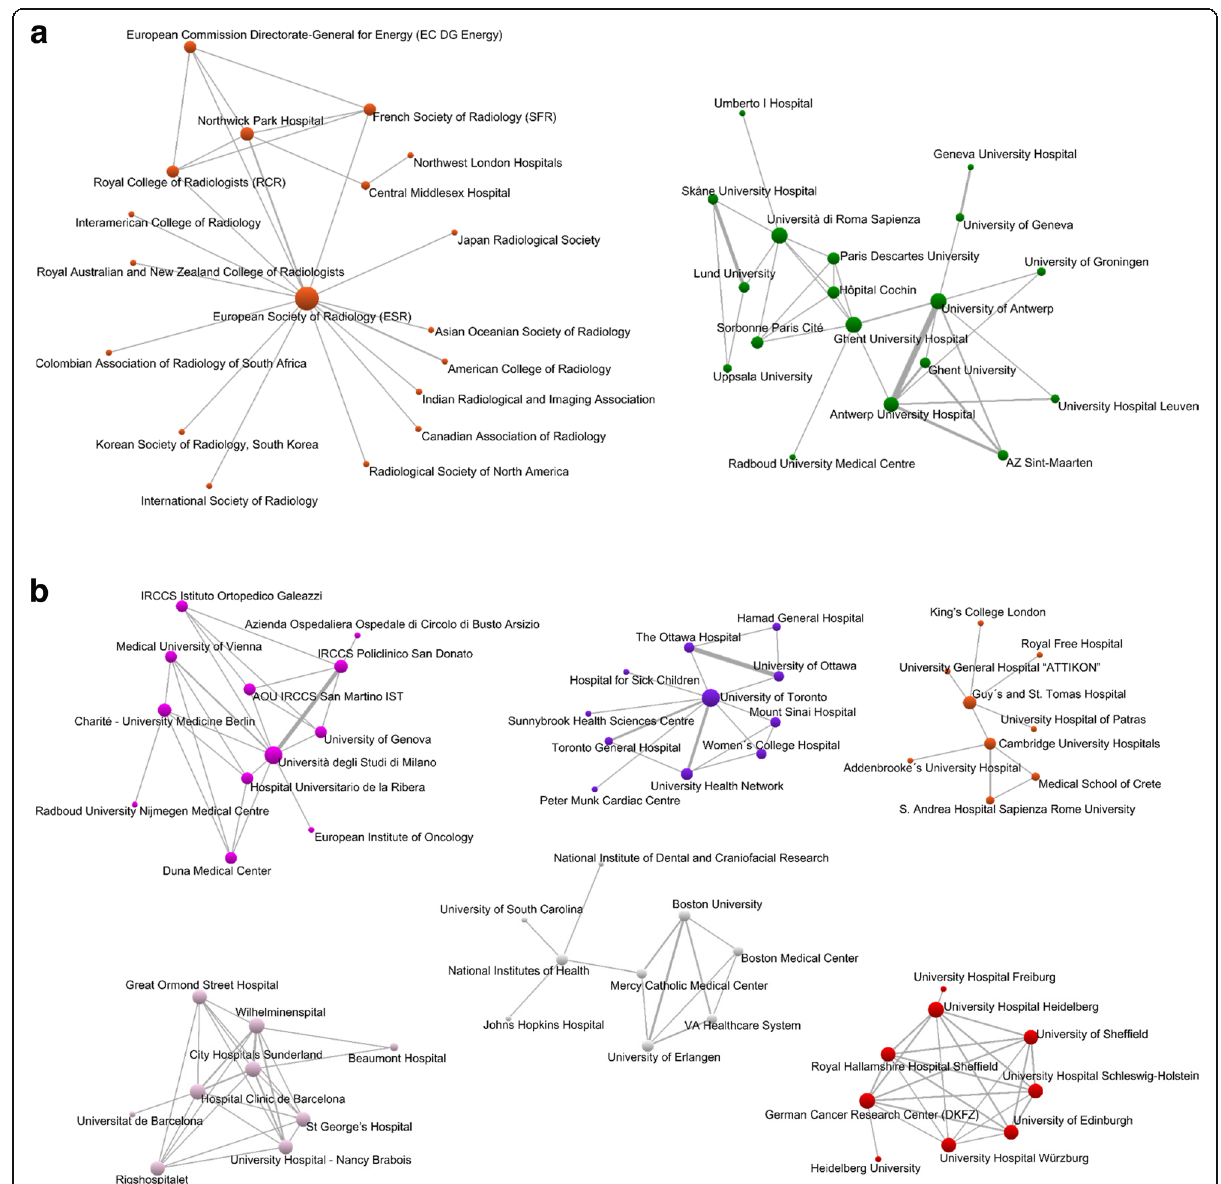
Fig. 5 Network of collaboration between institutions. a Groups with 21 institutions. b Groups between 9 to 11 institutions (source: Scopus